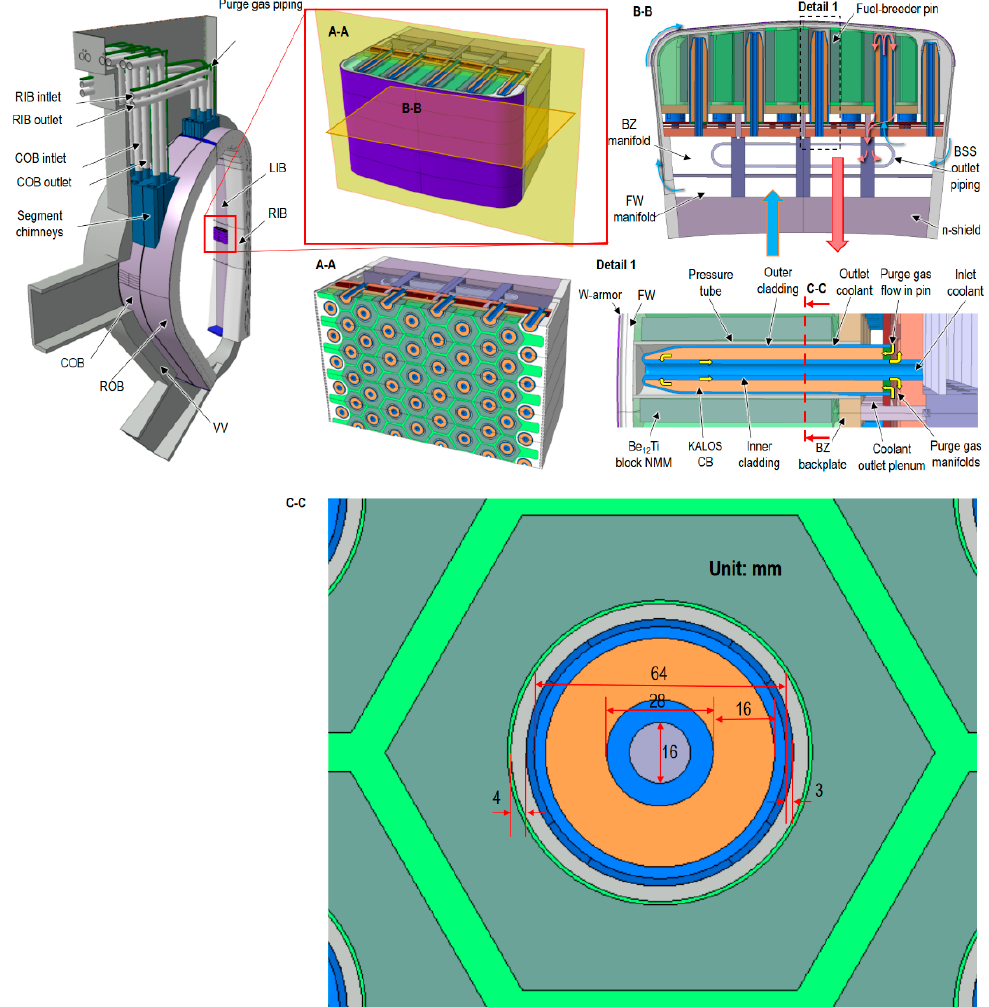
Figure 1. European DEMO HCPB blanket concept.